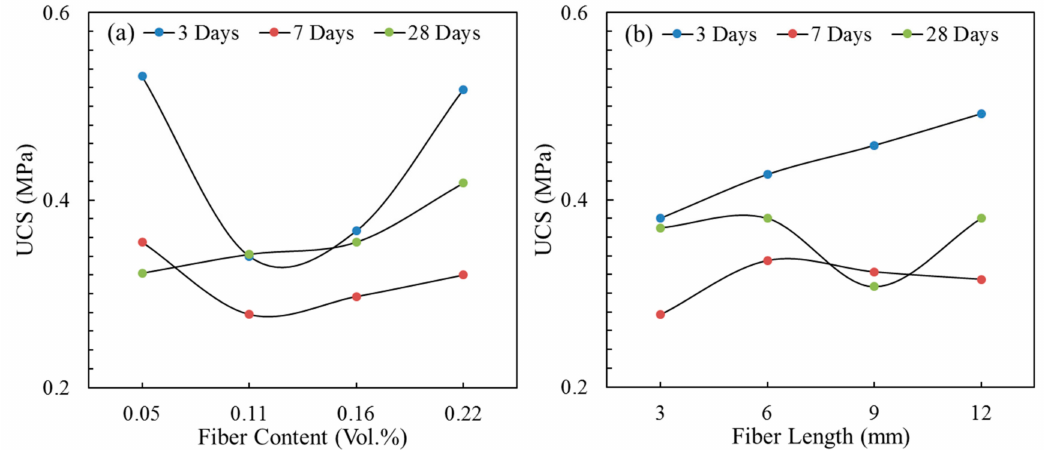
Figure 9. The e ff ects of the fiber parameters on the UCS: ( a ) fiber content; ( b ) fiber